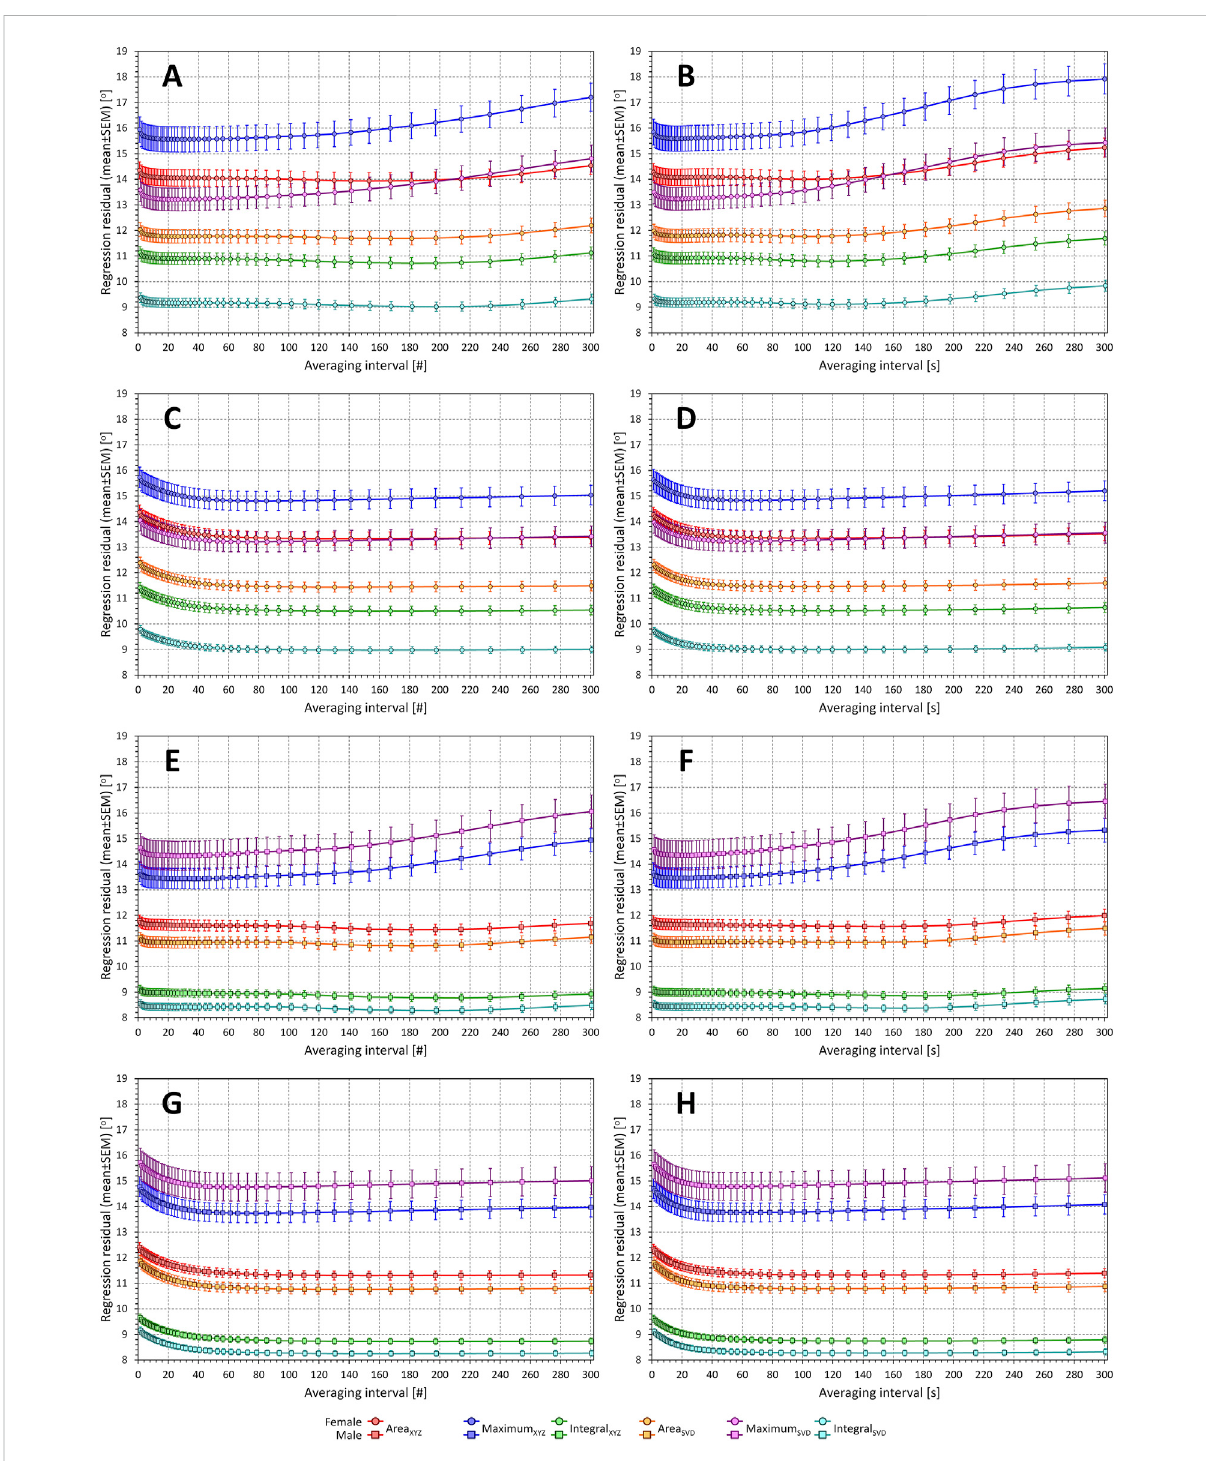
FIGURE 8 RegressionresidualsofQRS-Tanglerelatedtoaveragedprecedingheartrate.Ineachpanel,theindividualgraphscorrespondtodifferentQRS- T angle expressions and show the mean ± standard deviation of intra-subject residuals of second-degree polynomial regressions between QRS-T angle measurements and heart rates measured in preceding intervals of a given number of RR intervals [(#) — panels on theleft] or agiven number of seconds [(s) — panels on the right]. Panels (A) and (B) show the results in females with regressions involving only measurements preceded by variable heart rates; panels (C) and (D) show the results in females with regressions involving all measurements; panels (E) and (F) show the results in males with regressions involving only measurements preceded by variable heart rates; panels (G) and (H) show the results in males with regressions